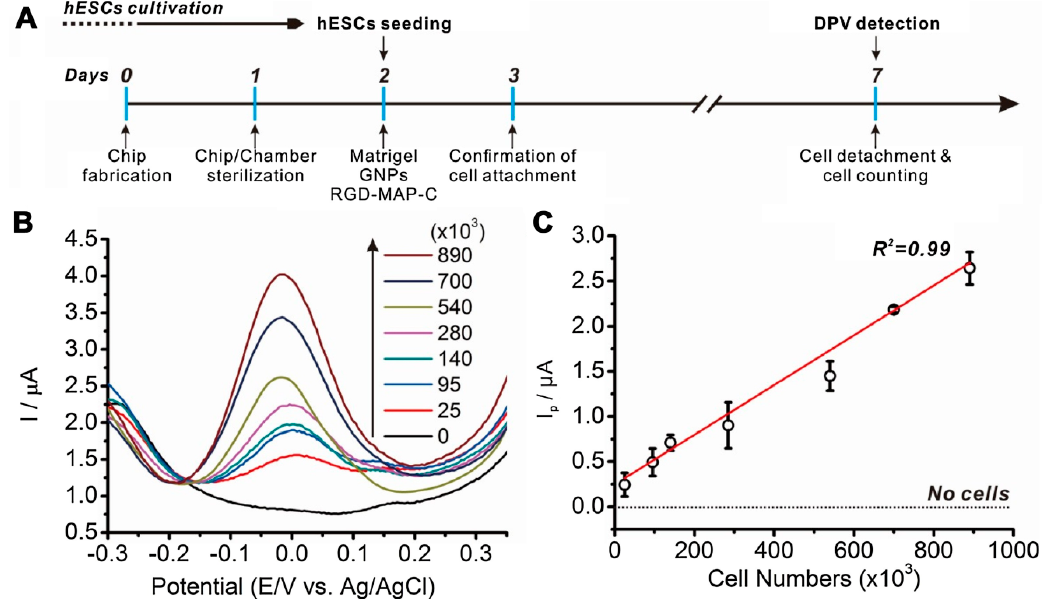
Figure 7. Linear correlations between differential pulse voltammetry (DPV) signals and number of human embryonic stem cells (hESCs): ( A ) brief protocol for cell chip-based electrochemical detection of hESCs; ( B ) DPV signals with indicative number of hESCs, from 25,000 cells to 890,000 cells, presented as an XY graph; and ( C ) linear correlations (R 2 ) between number of hESCs and the peak intensity (I p ) value calculated from the DPV signals. Reprinted with permission from [23]. Copyright 2018, Elsevier.